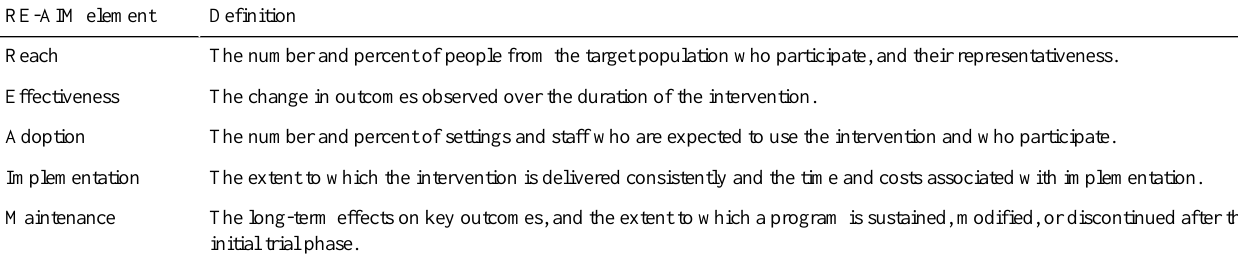
Table 2. RE-AIM elements and